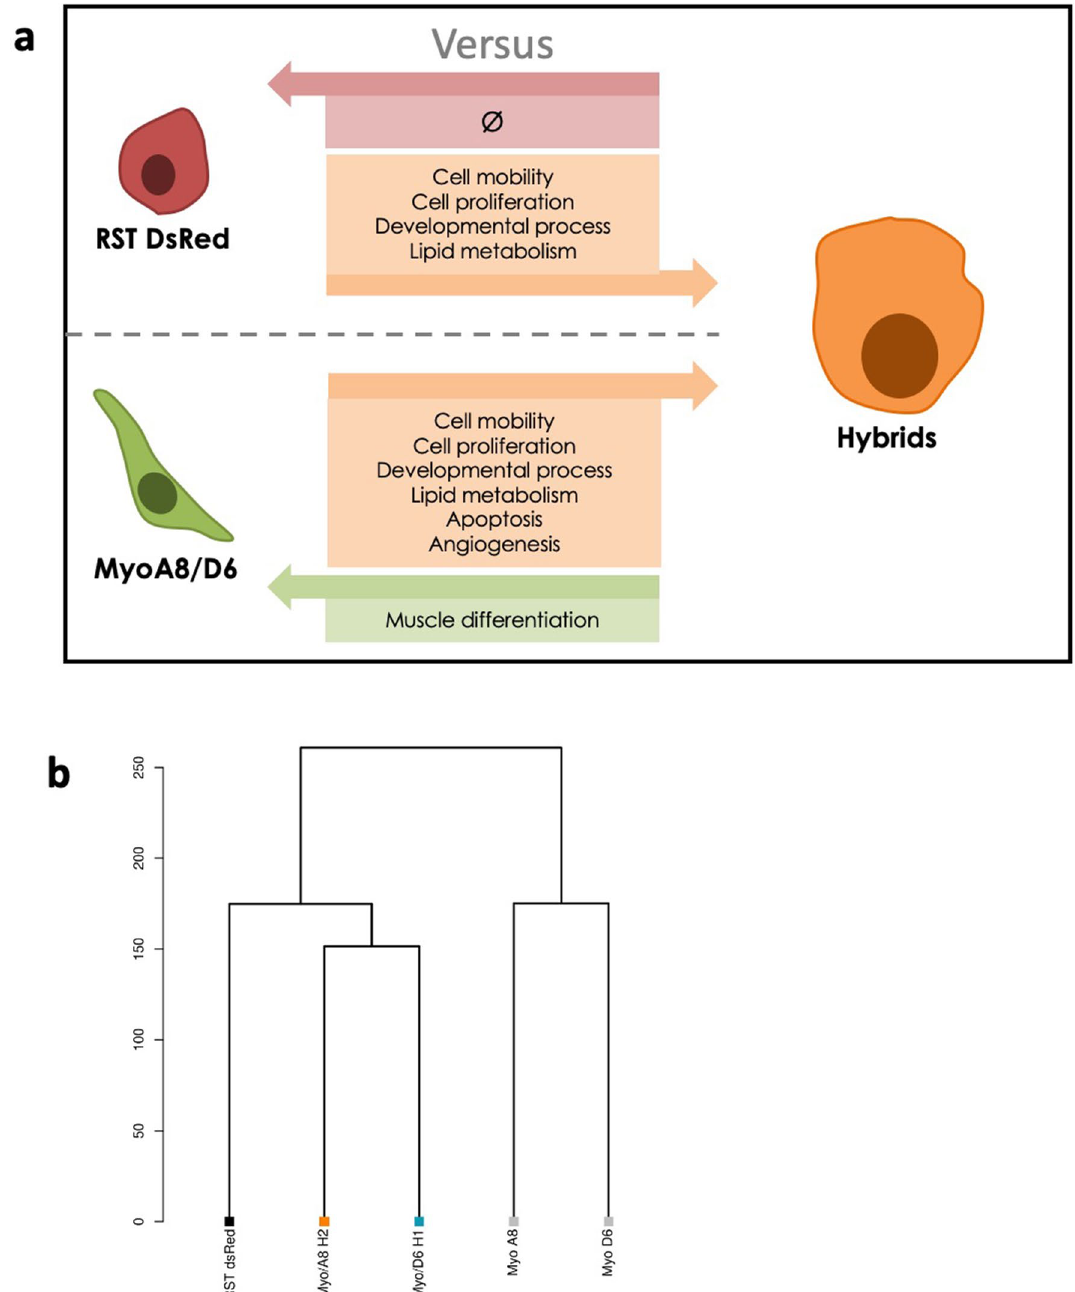
Figure 5. Hybrids presenttranscriptomic remodelling. ( a ) Schema of pathways overexpressed in parental cells compared to hybrids and in hybrids compared to parental cells. Each arrow indicates enriched Gene Ontologies in different cellular entities. On the top, pathways enriched in hybrids compared to RST DsRed are indicated in orange square. No pathway is enriched in RST DsRed compared to hybrids as indicated in the red square. On the bottom, pathways enriched in hybrids compared to myoblast cells are showed in orange square. Muscular differentiation pathway enriched in myoblasts compared to hybrids is indicated in green square. ( b ) Transcriptomic profile clustering of parental and hybrid cell